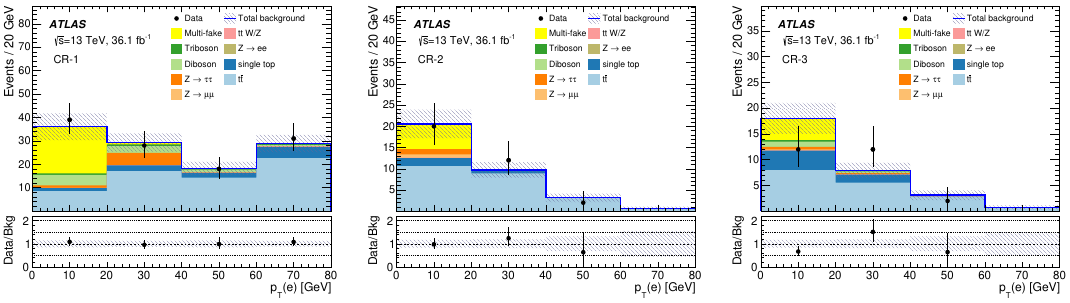
Figure 3. Third-lepton p T distributions in the control regions CR-1 (left), CR-2 (middle) and CR-3 (right) for the prompt HNL analysis in the muon channel, showing post-(cid:12)t background-only hypothesis including all the uncertainties and normalised in both CRs+SR. The total uncertainty in the background is shown as dashed